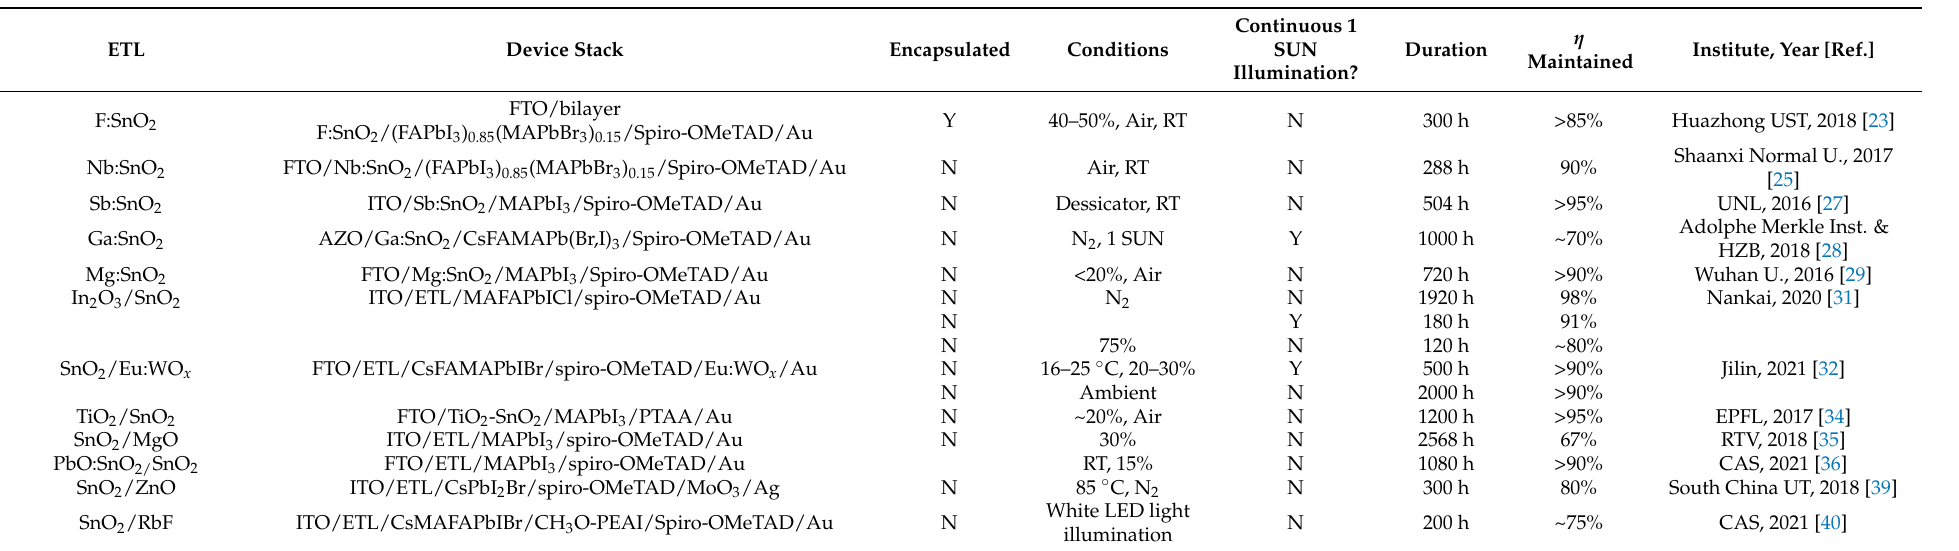
Table 9. Summary stability of ETL-modified perovskite-solar